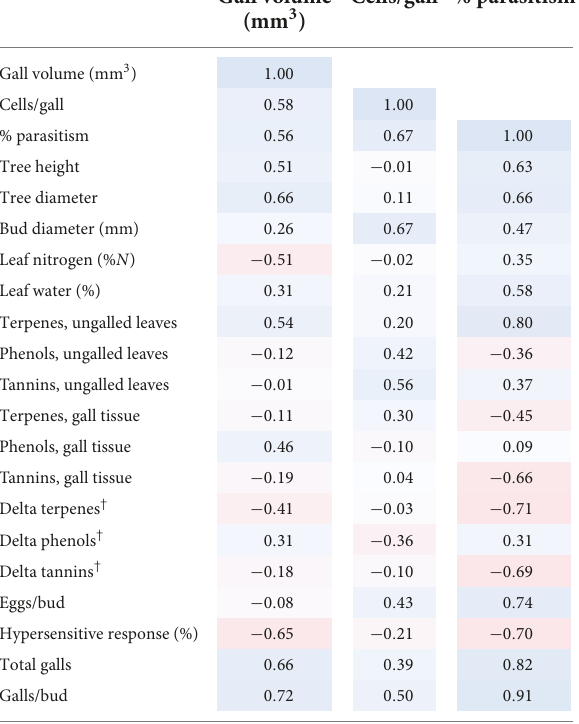
TABLE 5 Pearson correlations involving gall attributes for n = 6 clones that displayed normal